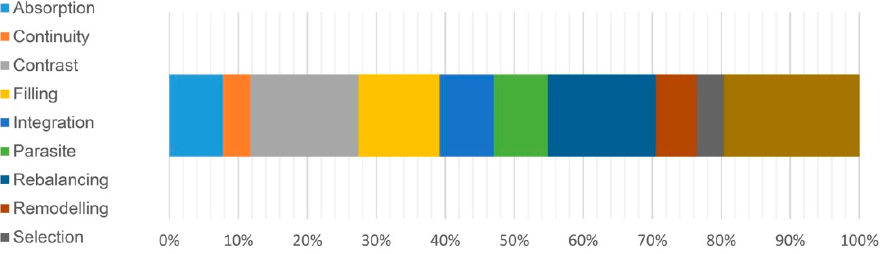
Figure 4. Percentage of recurrence of the strategies.